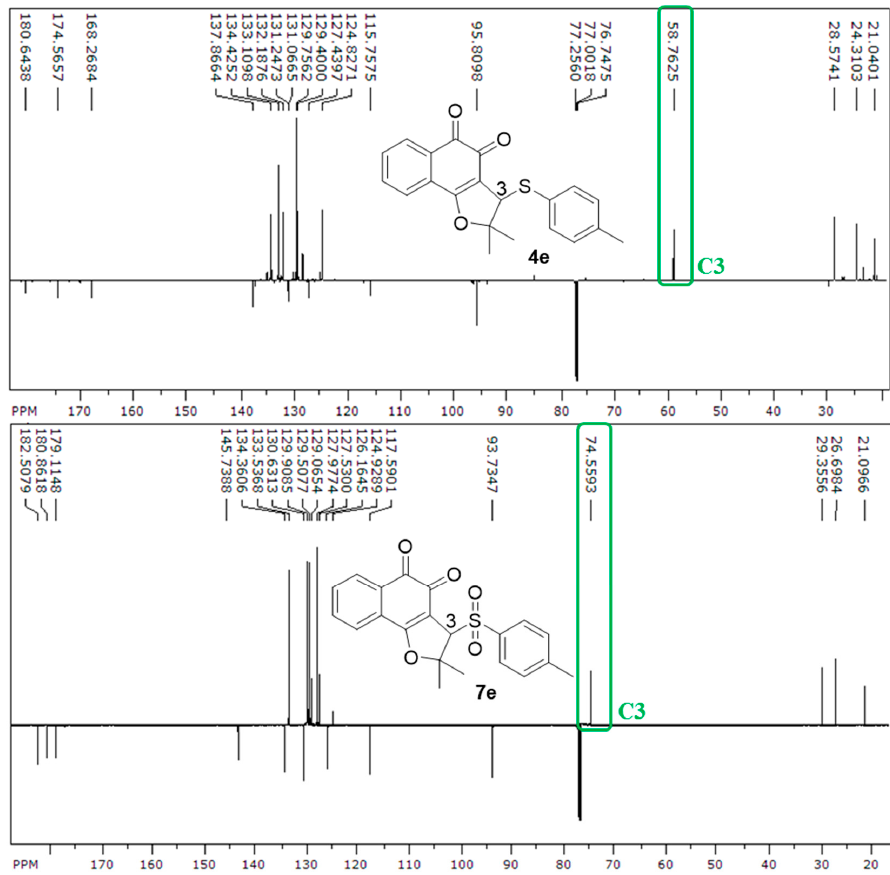
Figure 3. 13 C-Attached proton test ( 13 C-APT) spectra of 4e and 7e in CDCl 3 .